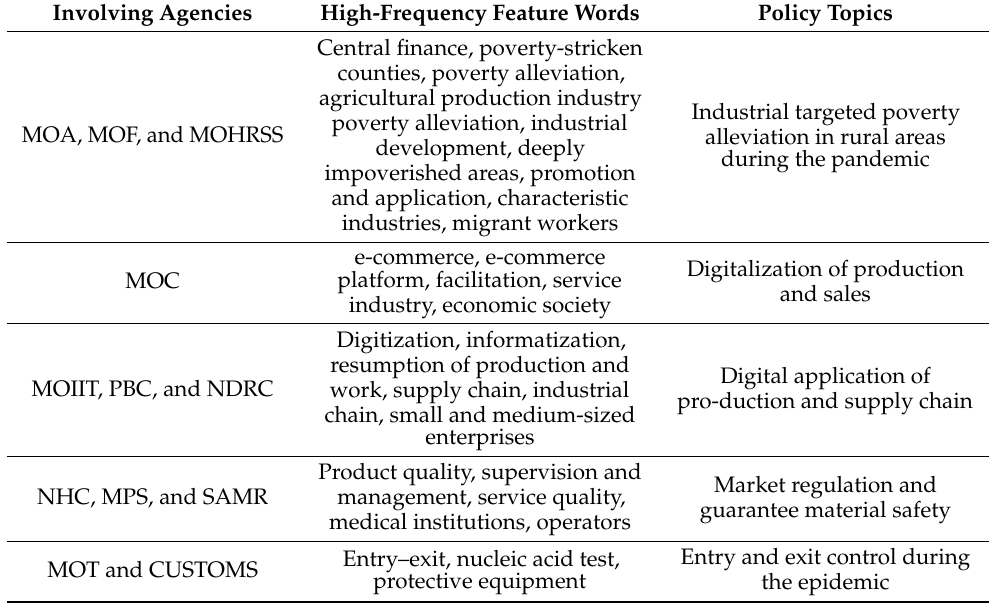
Figure 6. “Agency–topic” relationship network in the third phase. Table 5. Policy topics of interagency collaborative decision-making in the third